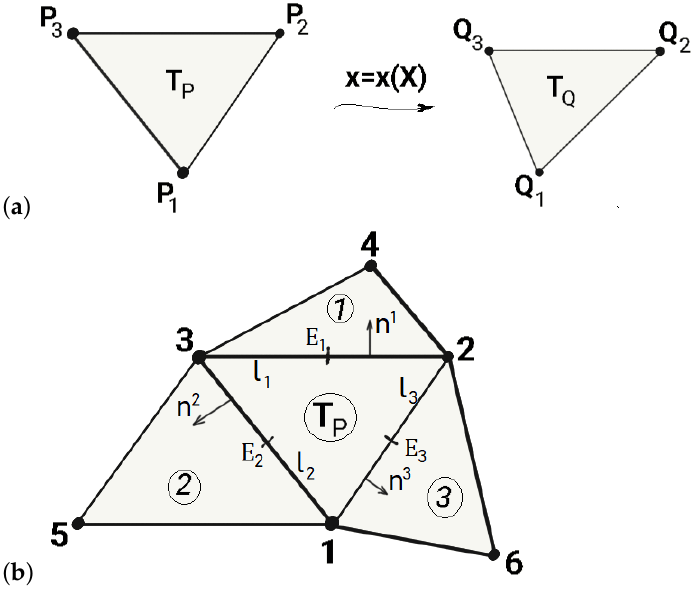
Figure 1. ( a ) Triangle before and after deformation. ( b ) Patch of elements including the central triangle T P and three adjacent elements (1, 2, and